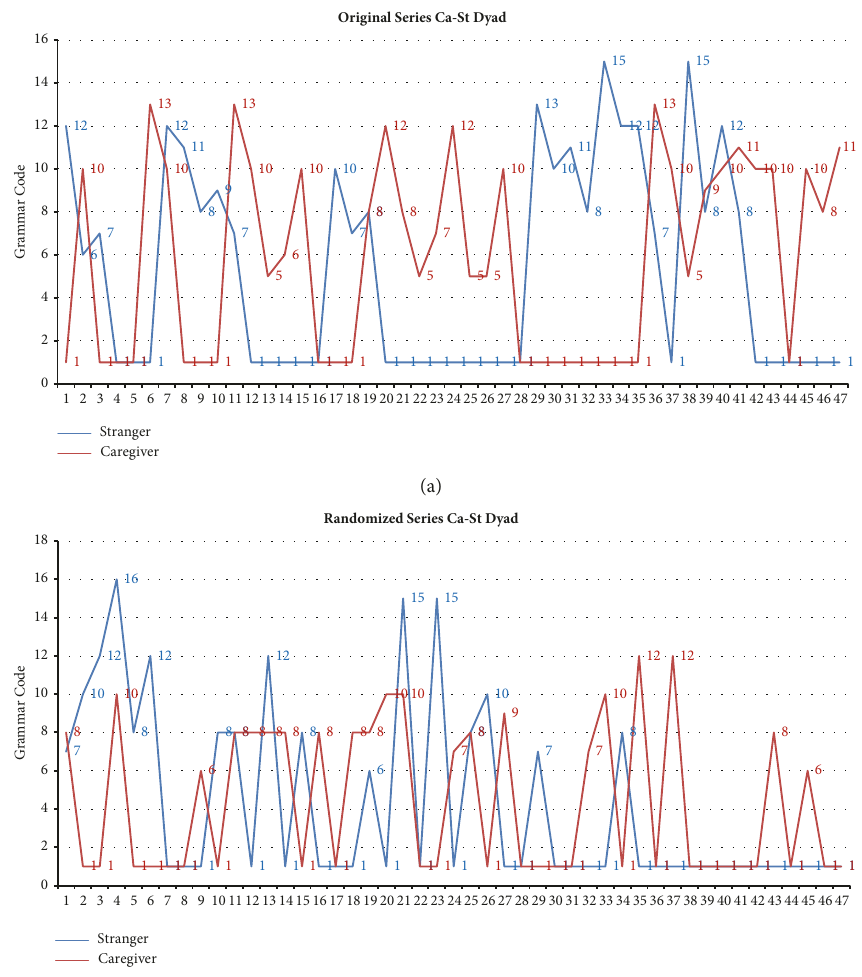
Figure 2: Panels (a) and (b) show the sequence of words that have been classified according to their grammatical function. In this segment of 47 events, only 12 categories appear. 1 = silence, 5 = article, 6 = pronoun, 7 = noun, 8 = verb, 9 = adjective, 10 = adverb, 11 = conjunction, 12 = preposition,13=interjection,15=adverbialphrase,and16=ownname.Grammarobservedinoriginalseries(Panel(a))showstypicalpatterns ofcommunicativeinteractionbetweencaregiverandstranger.Thistypicalpatterniscancelledwhenoriginaltimeseriesarerandomized(Panel